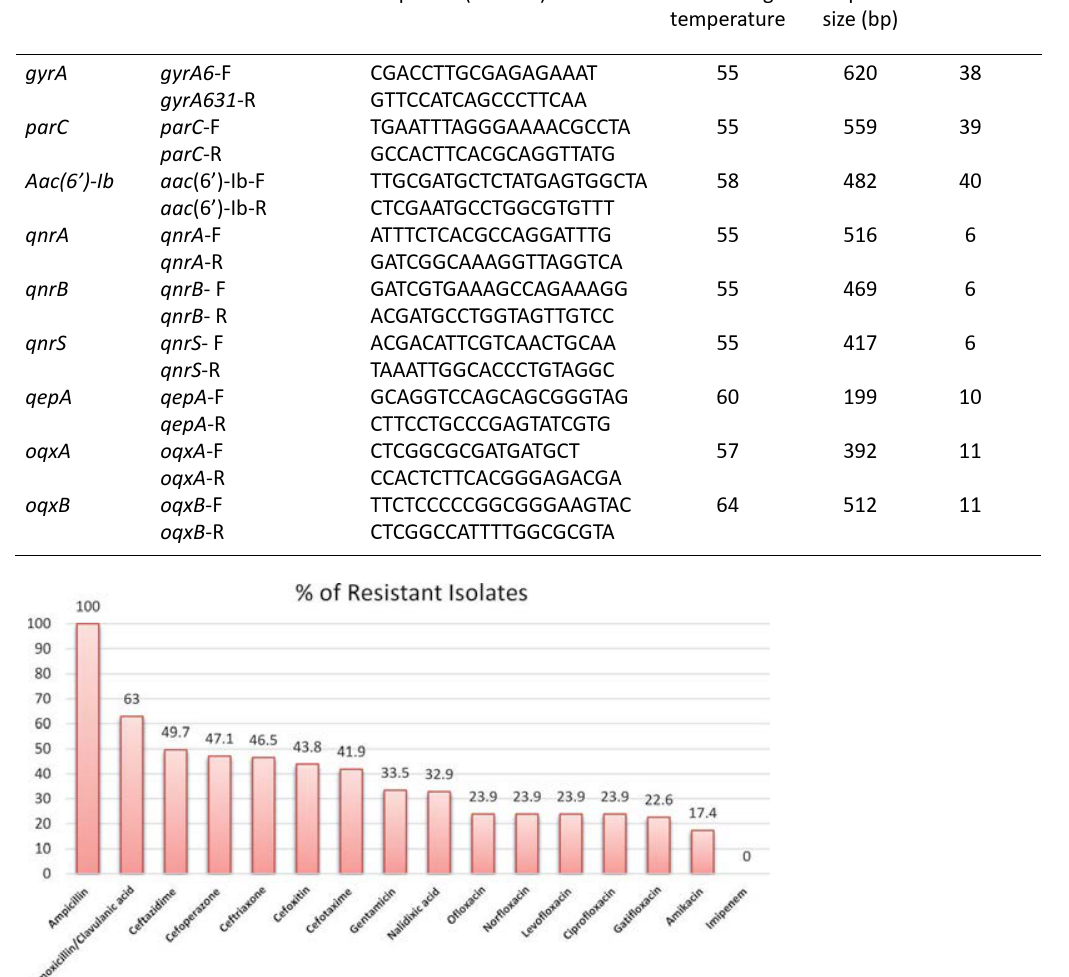
Fig. 1. Antibiotic Sensitivity pattern of isolated E.coli strains from urine samples of patients with UTIs